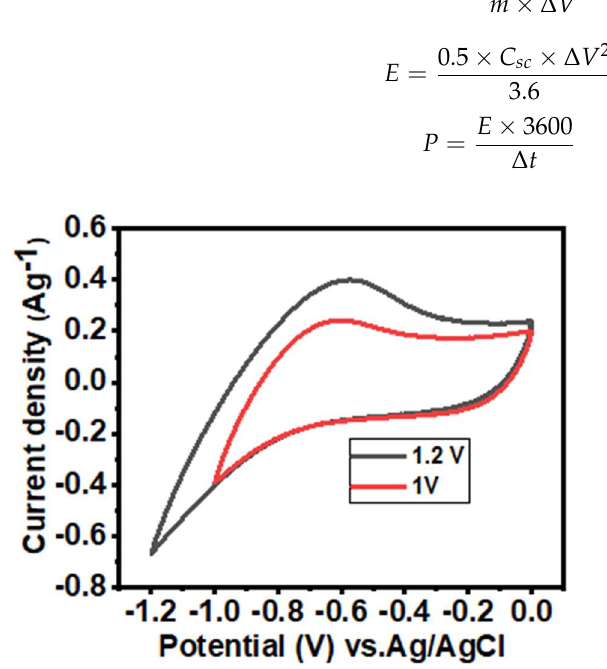
Figure A1. CV curves for α -Fe 2 O 3 -NF in − 1 V and − 1.2 V at 100 mV/s.